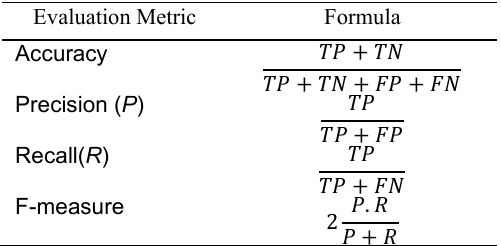
Table 5. Evaluation Parameter